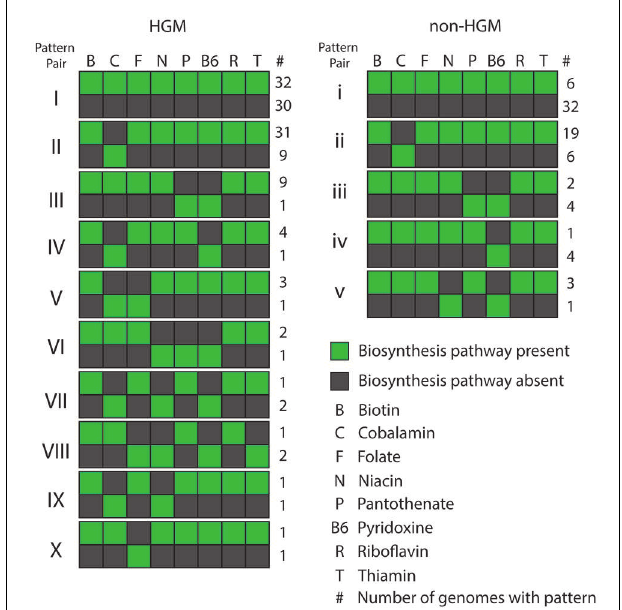
FIGURE 10 | Inversed pattern pairs of HGM and non-HGM genomes. The HGM genomes showed ten pairs of inversed patters, whereas the non-HGM contained 5 pairs.